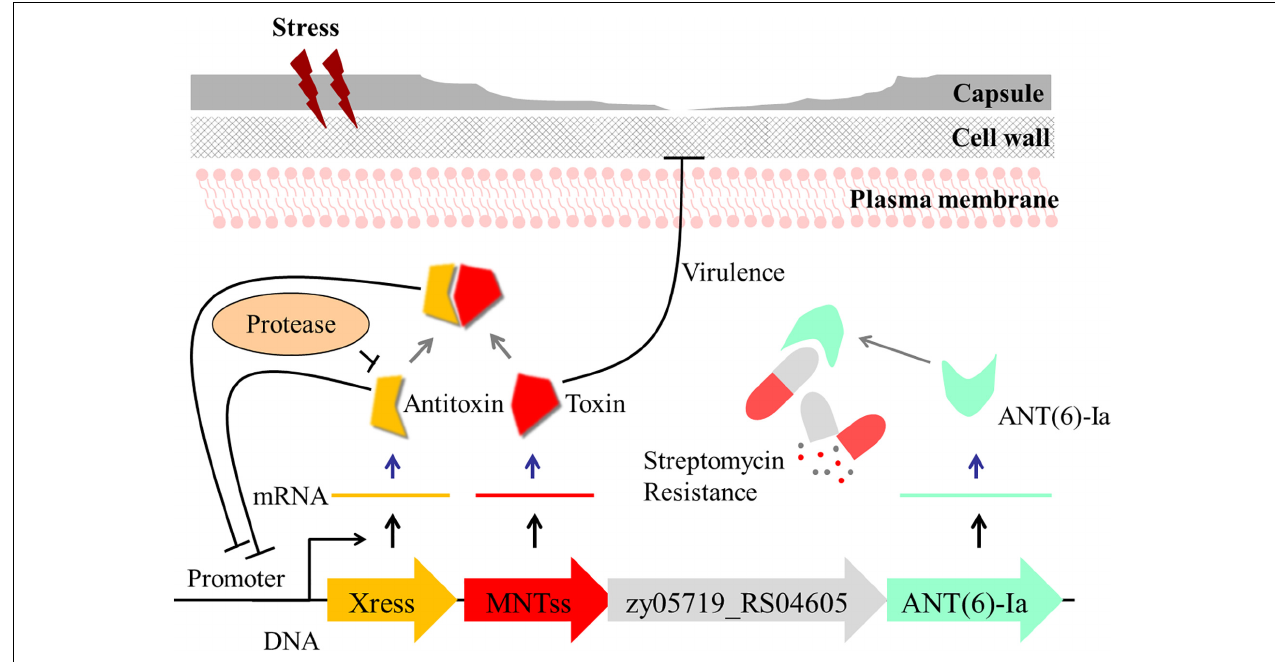
FIGURE 7 | Model illustrating the proposed regulation of drug resistance and role of Xress-MNTss in S. suis virulence. Under non-stressful conditions, Xress binds directly to MNTss to neutralize the toxicity of MNTss, while Xress and the Xress-MNTss complex bind directly to the promoter region to achieve auto-regulation. Under stressful conditions, the antitoxin is degraded by proteases, MNTss is released, the inhibitory effect of the toxin on zy05719_RS04605 and zy05719_RS04610 is removed. At the same time, MNTss accumulates in the cytoplasm, affecting capsule thickness and biofilm formation with consequent decrease in ZY05719